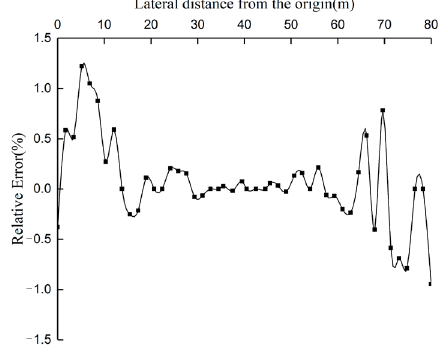
Figure 10. Relative error variation curve.